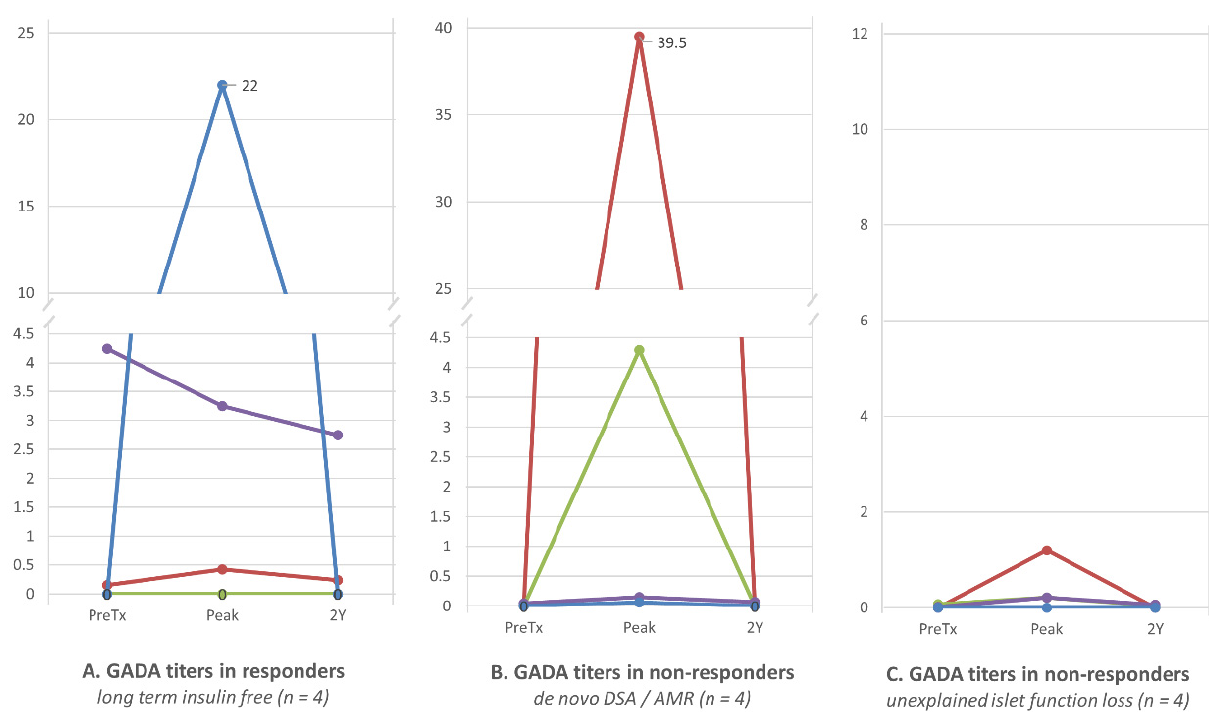
Figure 2. Trends of GADA in the islet transplant (ITx) responder and non-responder groups. There was no clear pattern of GADA level trends in relation to stability (responders) or declining or lack of islet graft function (non-responders) of islet function. Variability in GADA levels was similar in each group regardless of islet function and mechanism of islet injury. ( A ): GADA titers in responders. Four (4) patients who presented stable long-term (>2 years) insulin independence after only one IT ( n = 4). Each patient displayed a completely different trend of GADA. One patient who was seronegative remained so long-term. Despite stable islet function allowing for insulin independence over 5 years, another patient spiked GADA to 22 nmol/L at day 14 after IT and remained seropositive for 1 year. The remaining two patients were seropositive prior to IT and remained so afterwards, one with low and the other with much higher levels (4.24–2.68 nmol/L). ( B ): GADA titers in non-responders, who developed de novo DSA and loss of islet function ( n = 4). All patients in this group developed GADA with rising levels in parallel to DSA; however, GADA trends in this group were very similar to trends in responders without any DSA and islet dysfunction. ( C ): GADA titers in non-responders, who gradually loss their islet function without obvious reason ( n = 4). One patient remained GADA seronegative while losing partial islet graft function after each of three subsequent transplants. The remaining 3 patients presented either with persistent elevation or without an elevation of GADA following IT. GADA trends between patients in this group varied, and variability was similar to that observed in other groups. Autoantibody levels measured in